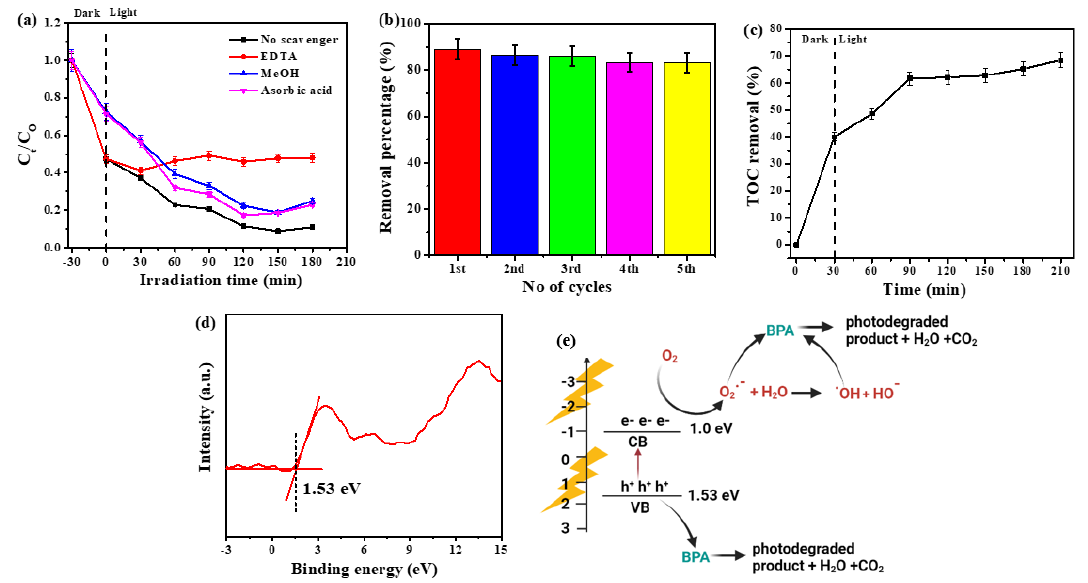
Figure 7. The ( a ) scavenging test and ( b ) reusability of 1.5CDs/g ‐ C 3 N 4 carried out under visible light irradiation ([BPA] = 20 mg L − 1 , catalyst dosage = 30 mg L − 1 , pH = 10). The TOC profile is provided in ( c ) and ( d ) is the VB ‐ XPS spectra of 1.5CDs/g ‐ C 3 N 4 . The flow of photogenerated e − /h + is illustrated in ( e ).